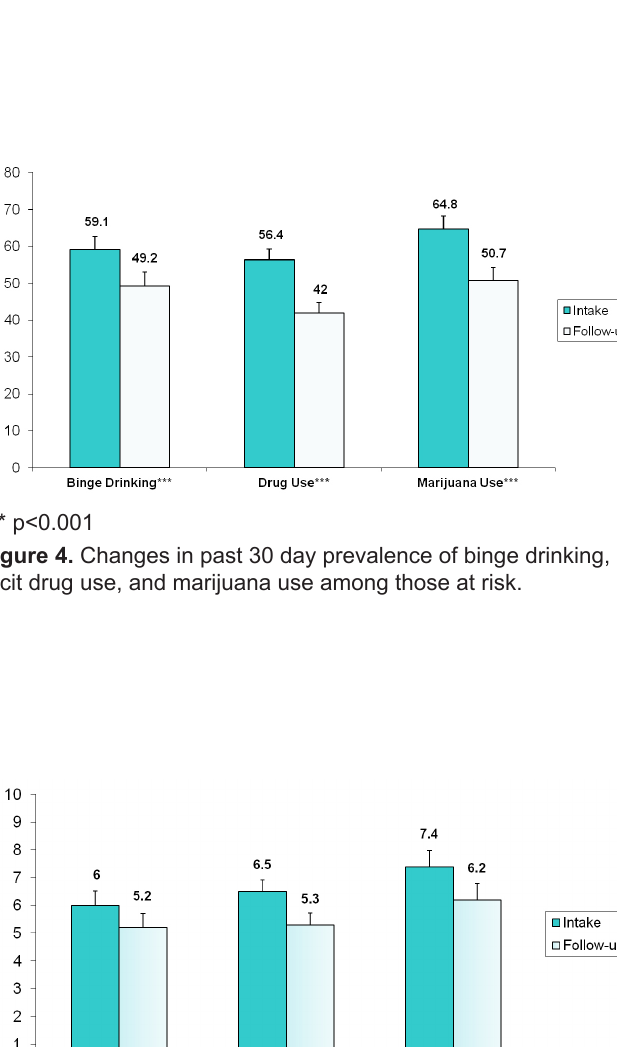
*** p<0.001 Figure 3. Overall changes in number of days in the past 30 that one binge drank, used illicit drugs, and used marijuana in the longitudinal and intent-to-treat sample (ITT).